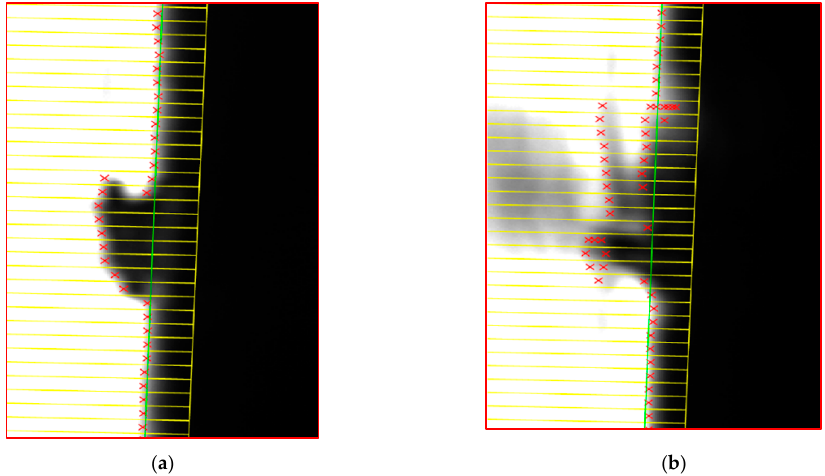
Figure 17. Influence of dust on image. ( a ) Influence of big dust on image. ( b ) Influence of complexed dust on image.